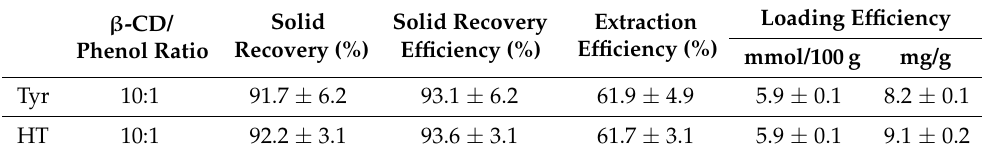
Table 3. Solid recovery, extraction, and loading efficiencies for 100 mM Tyr or HT solutions. Loading Efficiency Extraction Solid Solid Recovery β -CD/ Efficiency (%) Recovery (%) Efficiency (%) Phenol Ratio Tyr